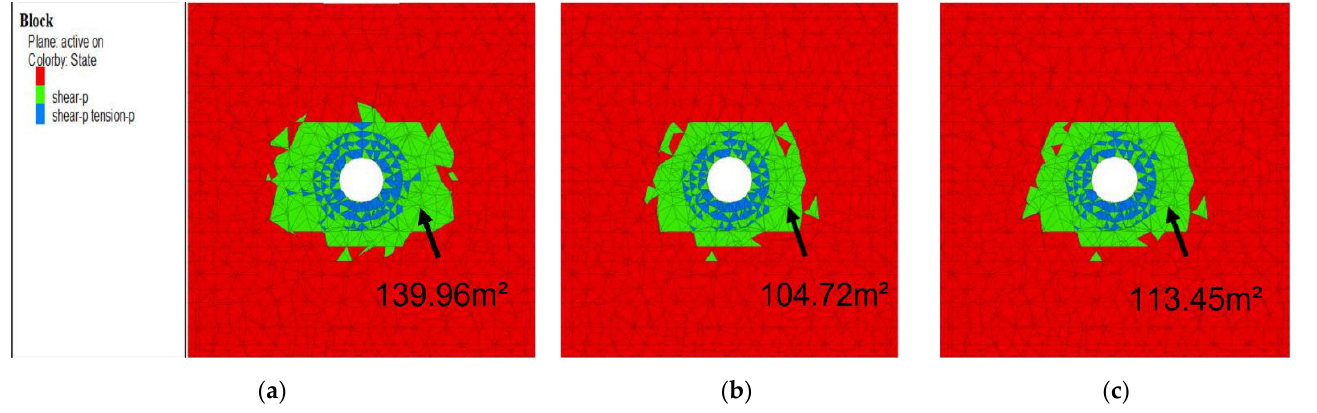
Figure 11. Failure zone distributions of the rock mass around the roadway of the support face: ( a ) unsupported, ( b ) radial support, and ( c ) non-radial support.